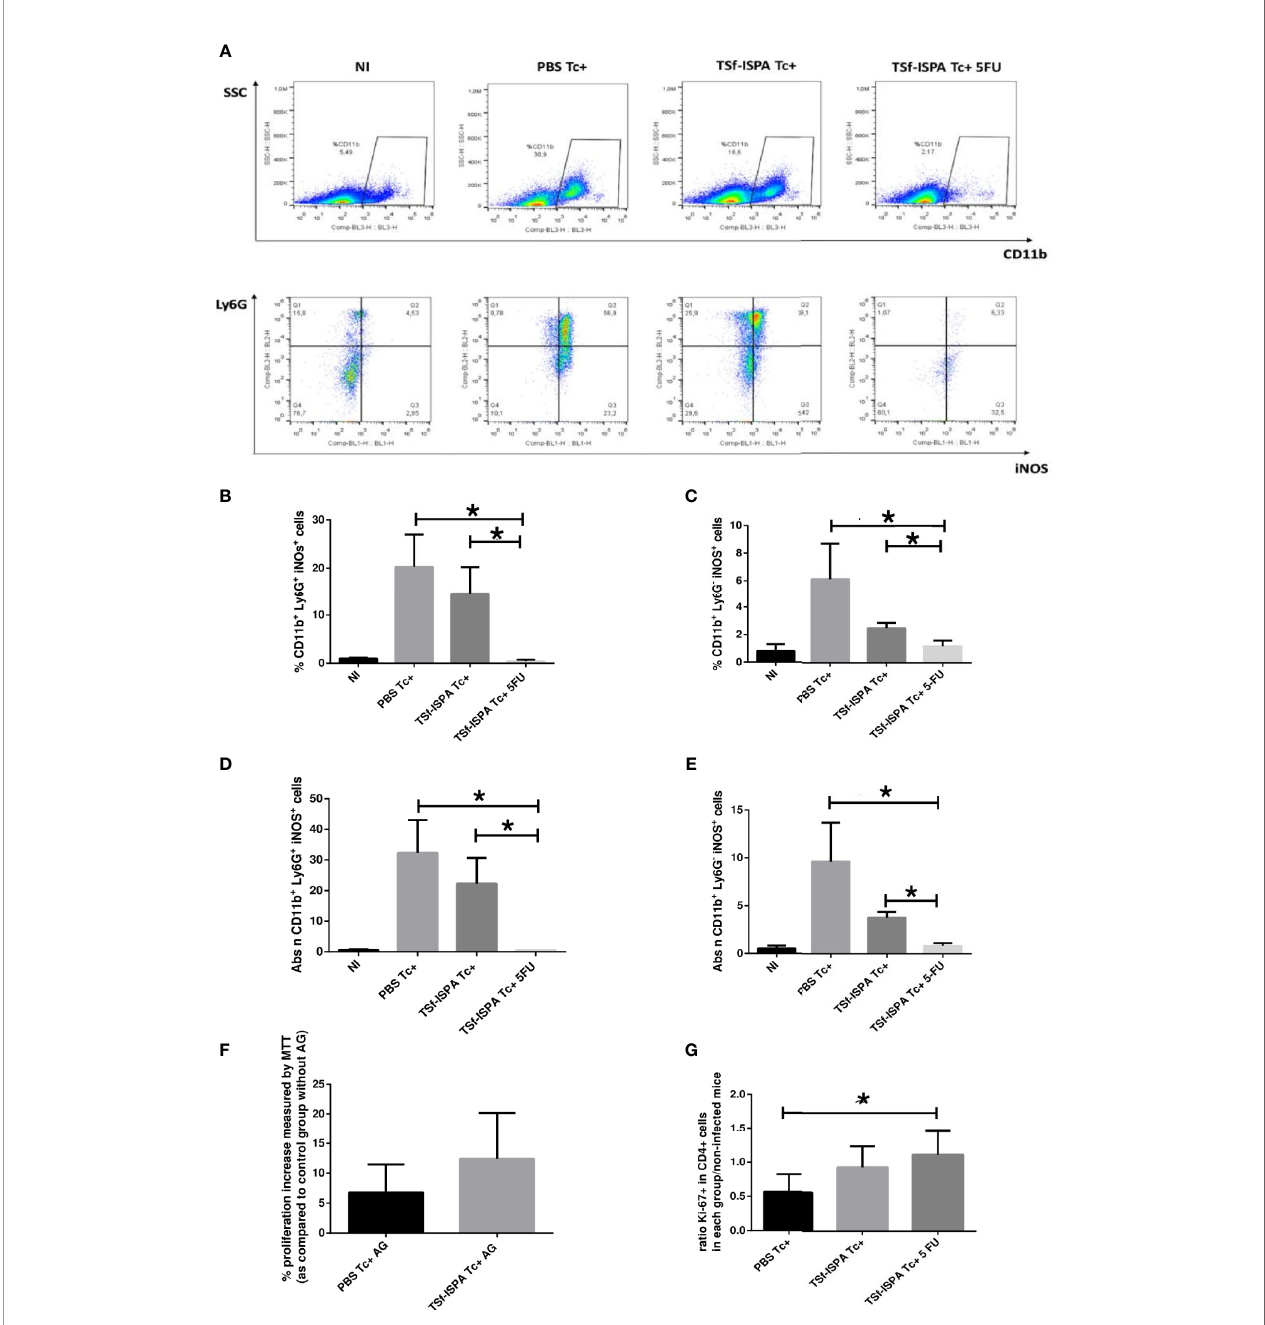
FIGURE 2 | iNOS expression by MDSC splenocytes. Mice immunized with TSf-ISPA or PBS were treated or not with 5FU and challenged with 900 trypomastigotes of the Tulahuen strain. At 21 days p.i., mice were sacri fi ced to analyze the expression of iNOS in CD11b+ Ly6G+ (G-MDSCs) and CD11b+ Ly6G- (which include M- MDSCs) cells by FACS in control non-infected (NI), PBS-inoculated and infected mice (PBS Tc+), TSf-ISPA immunized and infected mice (TSf-ISPA Tc+) and TSf- ISPA immunized, infected and 5FU treated mice (TSf-ISPA Tc+ 5FU). (A) Representative dot plots of the expression of CD11b vs side scatter and of iNOS vs Ly6G expression in the region indicated. (B) Percentage of CD11b+ Ly6G+ iNOS+ cells. (C) Percentage of CD11b+ Ly6G- iNOS+ cells, (D) Absolute number of CD11b+ Ly6G+ iNOS+ cells (x10 6 ). (E) Absolute number of CD11b+ Ly6G- iNOS+ cells (x10 6 ). (F) Splenocytes from NI, PBS Tc+ and TSf-ISPA Tc+ mice were cultured and stimulated with ConA, T. cruzi homogenate and aminoguanidine (AG), or with ConA, T. cruzi homogenate and without AG, an iNOS inhibitor. After 72 hs, MTT was used to measure proliferation increase using the formula explained in materials and methods. (G) Splenocytes from each experimental group were cultured and stimulated with conA and T. cruzi homogenate. After 72 hs, proliferation was measured by FACS using the Ki-67 proliferation marker and the formula detailed in materials and methods. Data are expressed as means + standard deviations. Results are representative of two independent experiments (n = 3-5 mice per group, according to the survival of the experiment) *p < 0,05 Mann-Whitney test was used for comparison between indicated